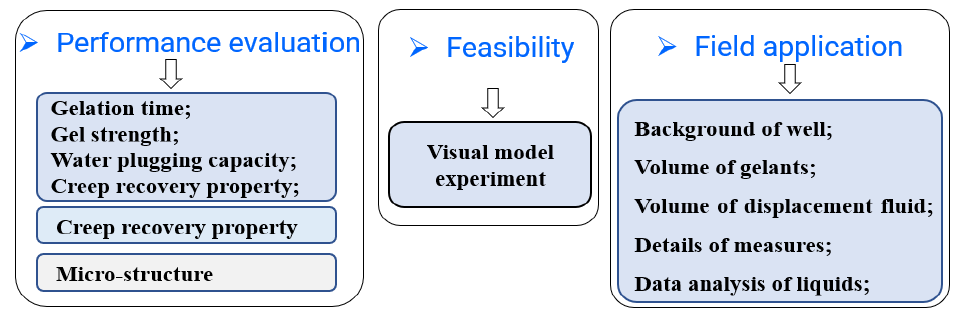
Table 1. Composition of Y oil-field formation water.